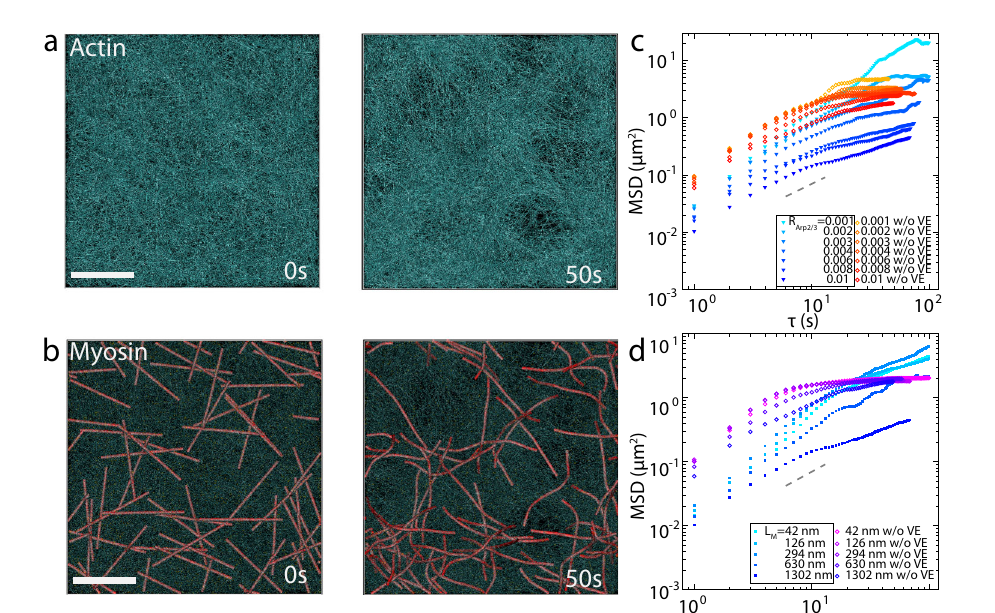
conditions. (* p <0.05, **** p <0.0001, and ns is not signi fi cant. p (74nM Arp & 0.74nM Arp) = 0.0148, p (74nM Arp & 83nM mDia1) = 4.34e-5, p (74nM Arp & 830nM mDia1) = 0.0172, p (no nucleator & no nucleator + blebb) = 0.0229. N myo = 3444,3668,2258,2588,668,1851,and 775foreachconditionfromlefttoright. N = 3 independent experiments for each condition. Two tailed t test. Error bars represent s.d. of the mean. Source data are provided as a Source Data fi